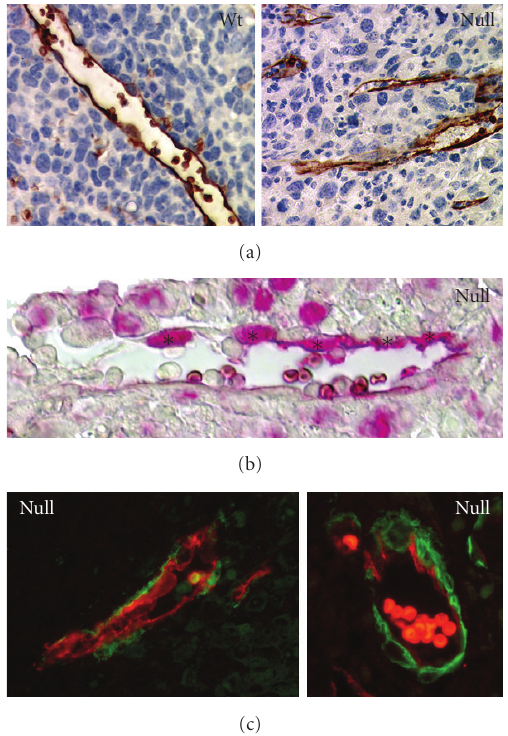
Figure 2: (a) Aquaporin-1 immunostaining of endothelial cells and blood vessels in subcutaneous Lewis lung carcinoma (LLC1) 14 days after inoculation into Pparb + / + and Pparb − / − mice (brown stain). Areas of tumor cell necrosis are obvious in the vicinity of the aberrant vascular structures in Pparb − / − mice. (b) PCNA (proliferating cell nuclear antigen) staining of an LLC1 tumor section from a Pparb − / − mouse. The red stain shows a high fraction of proliferating endothelial cells lining the tumor microvascular structures (denoted by asterisks; 38.7% in Pparb − / − mice versus 16.6% in Pparb + / + mice) [31]. (c) Aquaporin-1/ α -smooth muscle actin double immunofluorescence of LLC1 tumors from Pparb − / − mice, showing hallmarks of a hyperplastic stroma. Red: aquaporin- 1, green: α -smooth muscle actin.